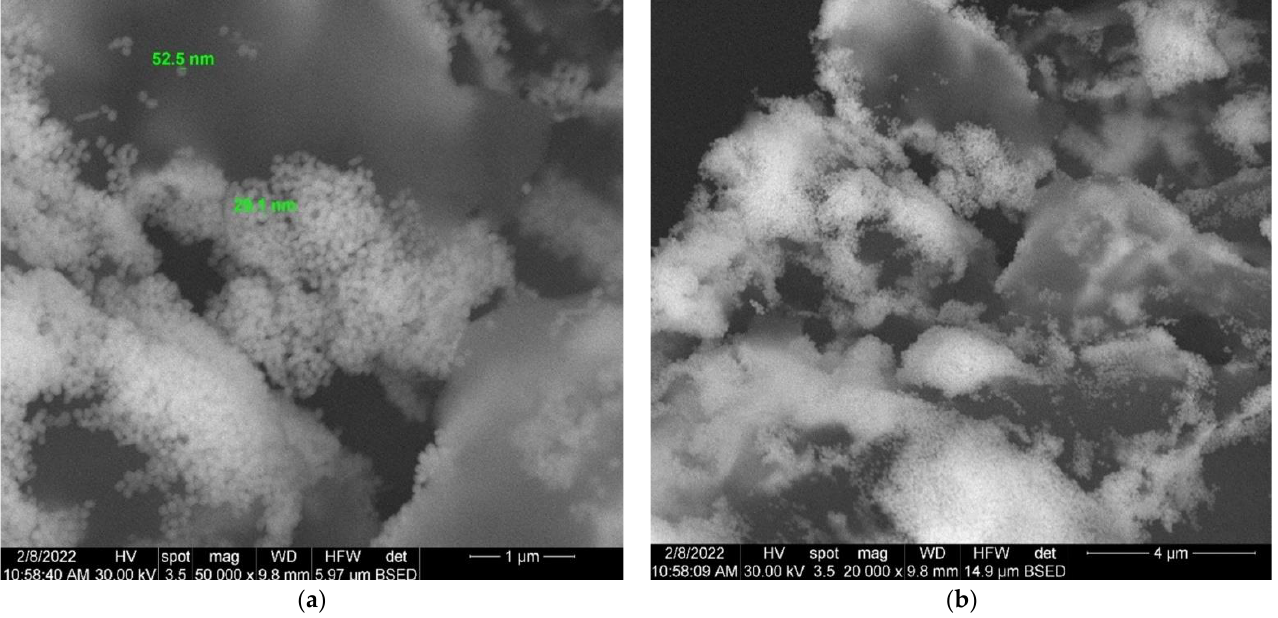
Figure 9. ( a ) Two-dimensional image of the phytocarrier system obtained by the SEM technique (magnitude: 1 μm). ( b ) Two-dimensional image of the phytocarrier system obtained by the SEM technique (magnitude: 4 μm).